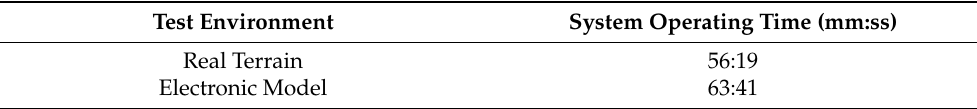
Table 5. System operating time as measured in real terrain and yielded by the electronic